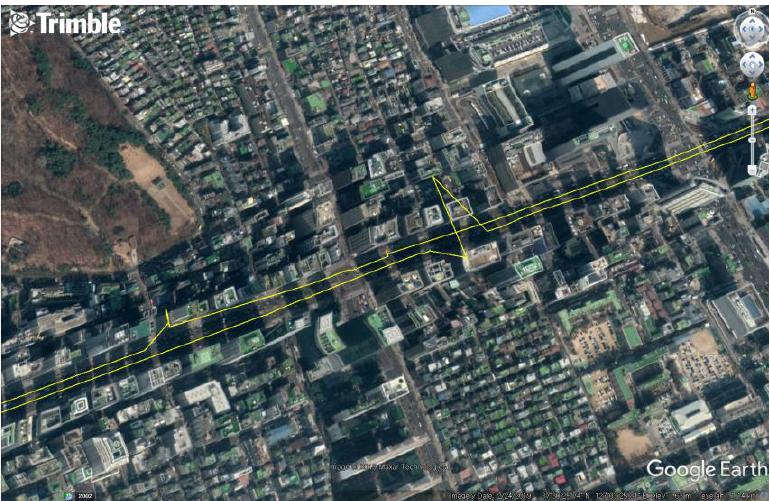
Figure 2. Trajectory of a dynamic land vehicle in an urban multipath area.